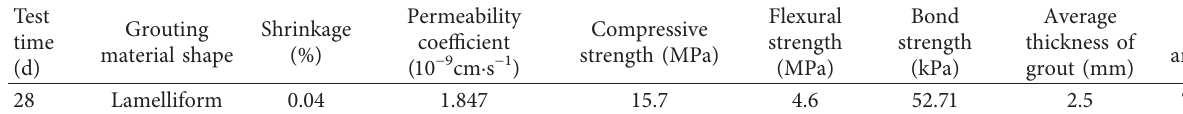
Figure 13: Critical state lines on q - p ′ planes from WT. Table 5: The grouting parameters of field tests.